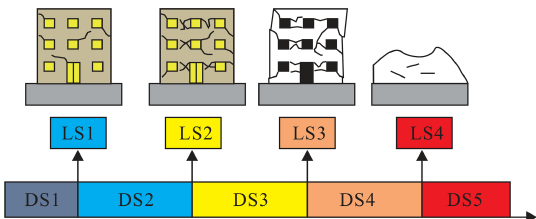
Figure 1. Corresponding relation between structural damage states (DS1, D2, D3, DS4, DS5) and limit states (LS1, LS2, LS3, LS4) (modified from Wenliuhan et al.,